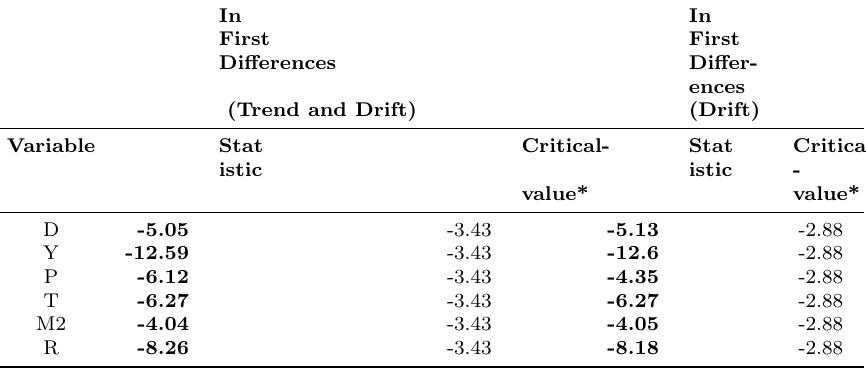
In First Differ- ences